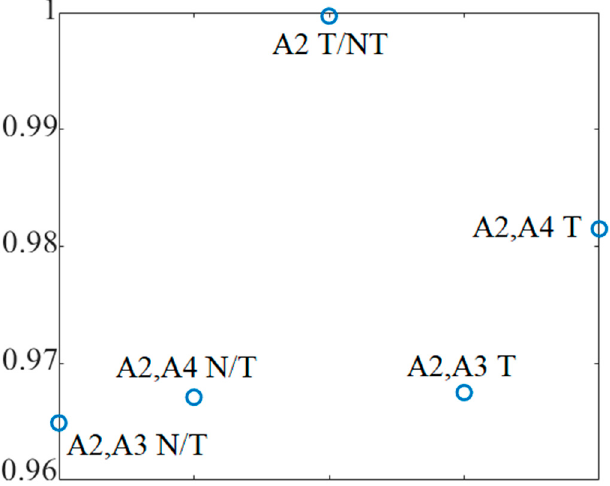
Figure 12. Simulated setup of the antenna array elements in on-body conditions (with tumour (T) and without tumour (N/T)).